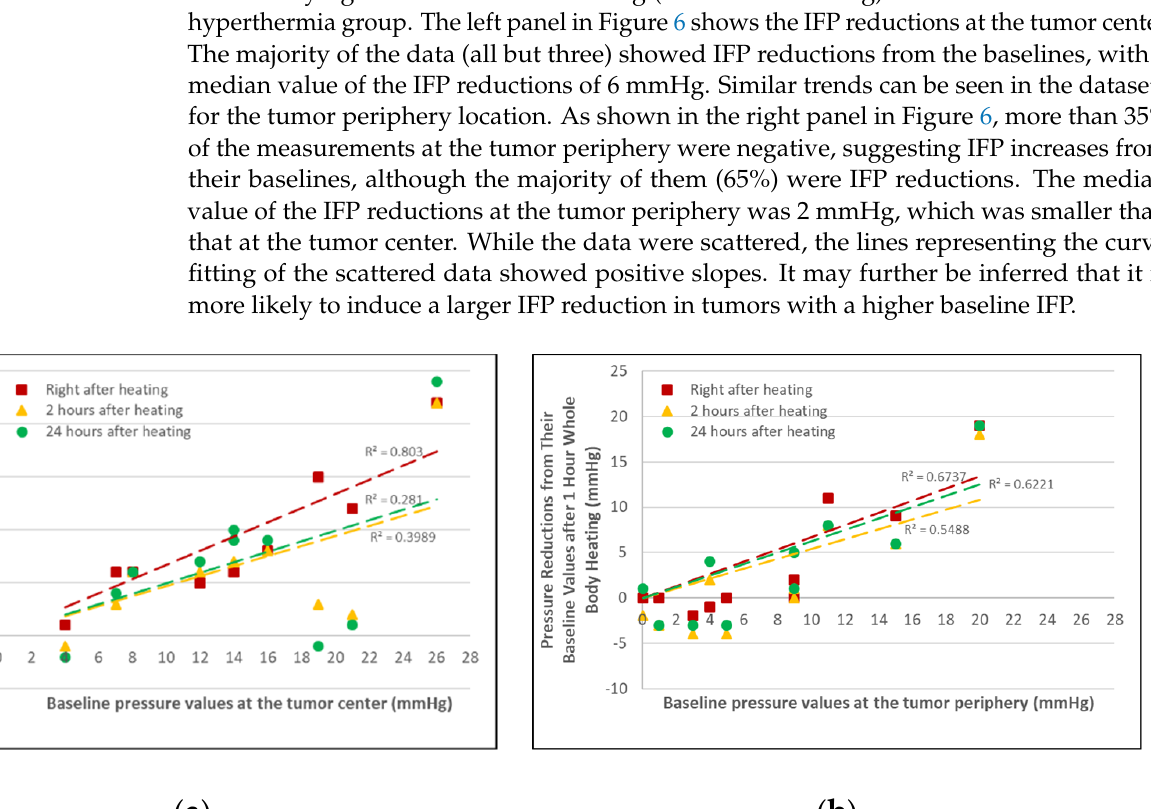
Figure 6. The relationship between the IFP reductions and their baseline IFPs in the 1 h of whole-body heating group. The data collected at various time instants post-heating are represented by different symbols. The lines are the linear curve fittings to the scatter data. ( a ) The left panel represents data at the tumor center, and ( b ) the right panel represents data at the tumor periphery.